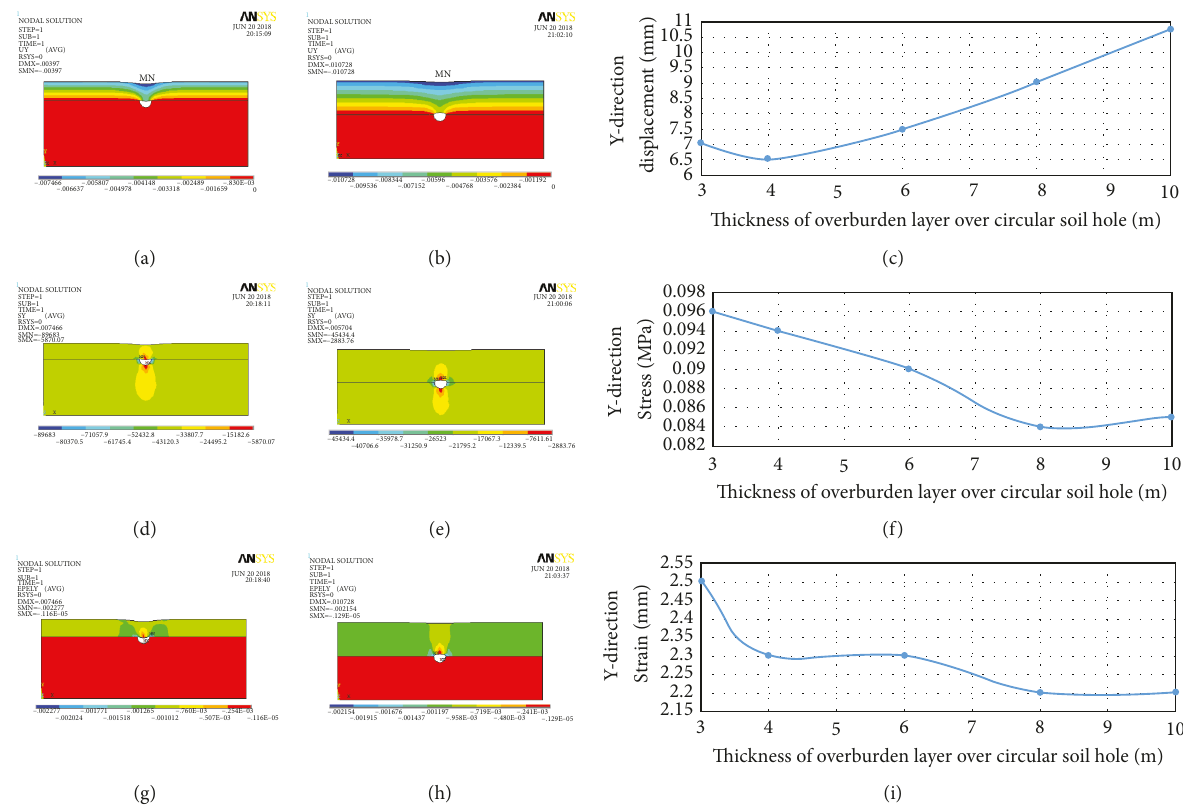
Figure 7: q � 34.66kPa scenario. Results of displacement cloud map: (a) H � 6m and (b) H � 10m; (c) displacement curve; stress cloud map: (d) H � 6m and (e) H � 10m; (f) stress curve; strain cloud map: (g) H � 6m and (h) H � 10m; (i) strain